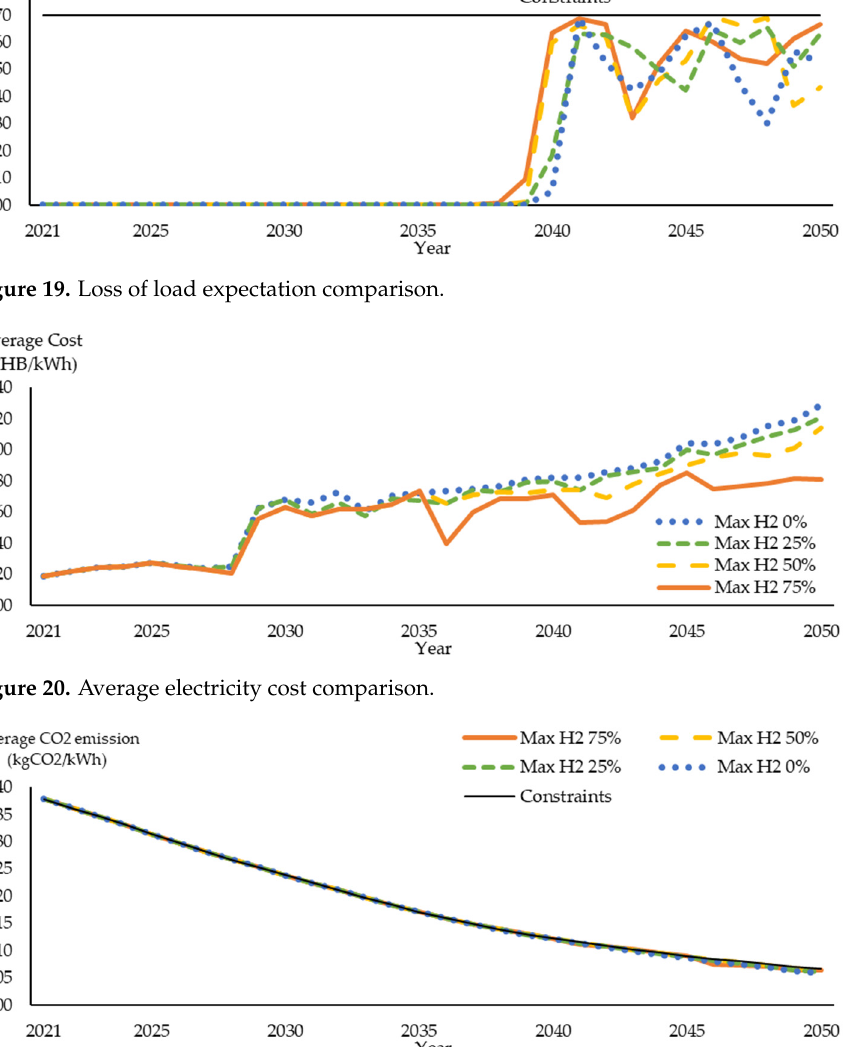
Figure 21. Average carbon dioxide emission comparison. Table 3. Land use for PVBESS installation by